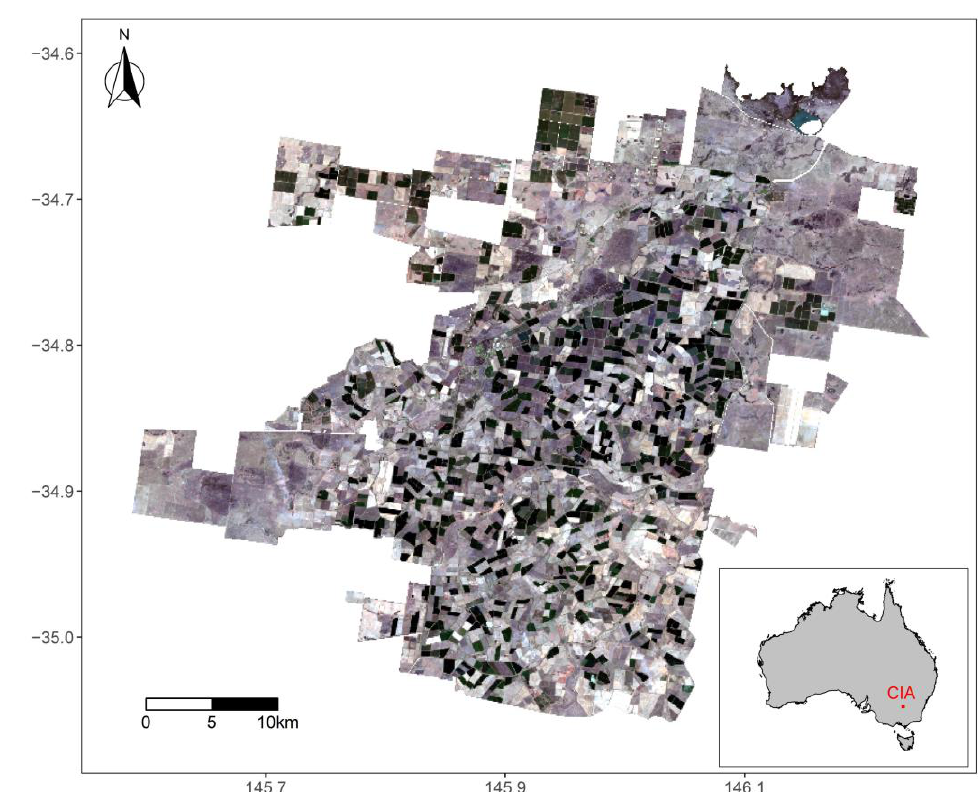
Figure 1. The study area—Coleambally Irrigation Area (CIA). The background image comes from the true-color Landsat composite obtained in summer 2013 – 2014. The inserted map at the bottom-right corner shows the location of the CIA in Australia.